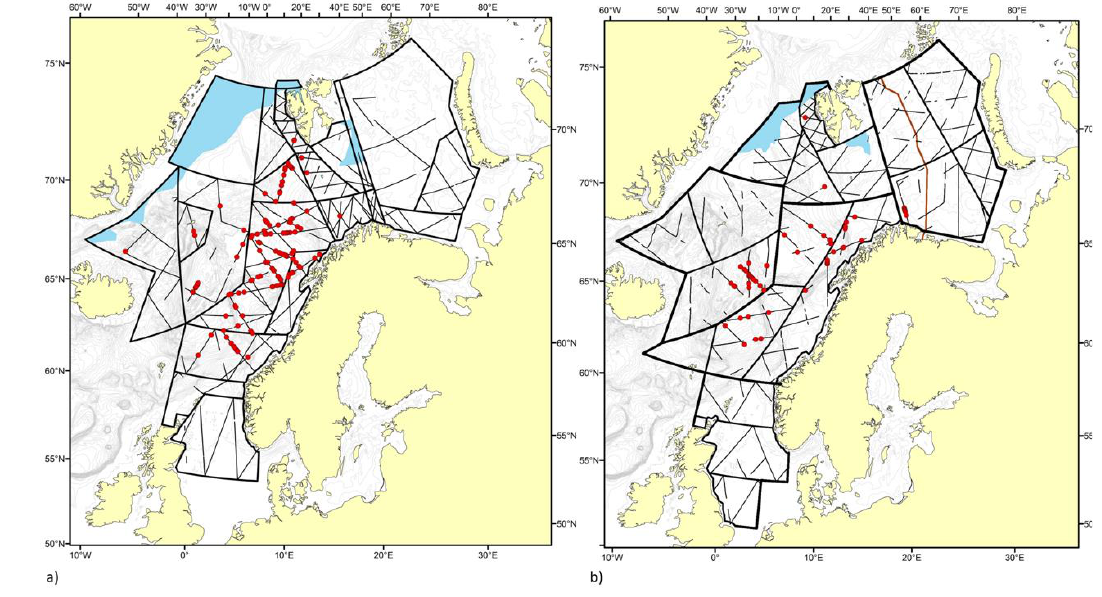
Figure 7. Distributions of sightings recorded as sperm whales during (a) the 2002 – 2007 surveys and (b) the 2008 – 2013 surveys. The blue areas represent ice